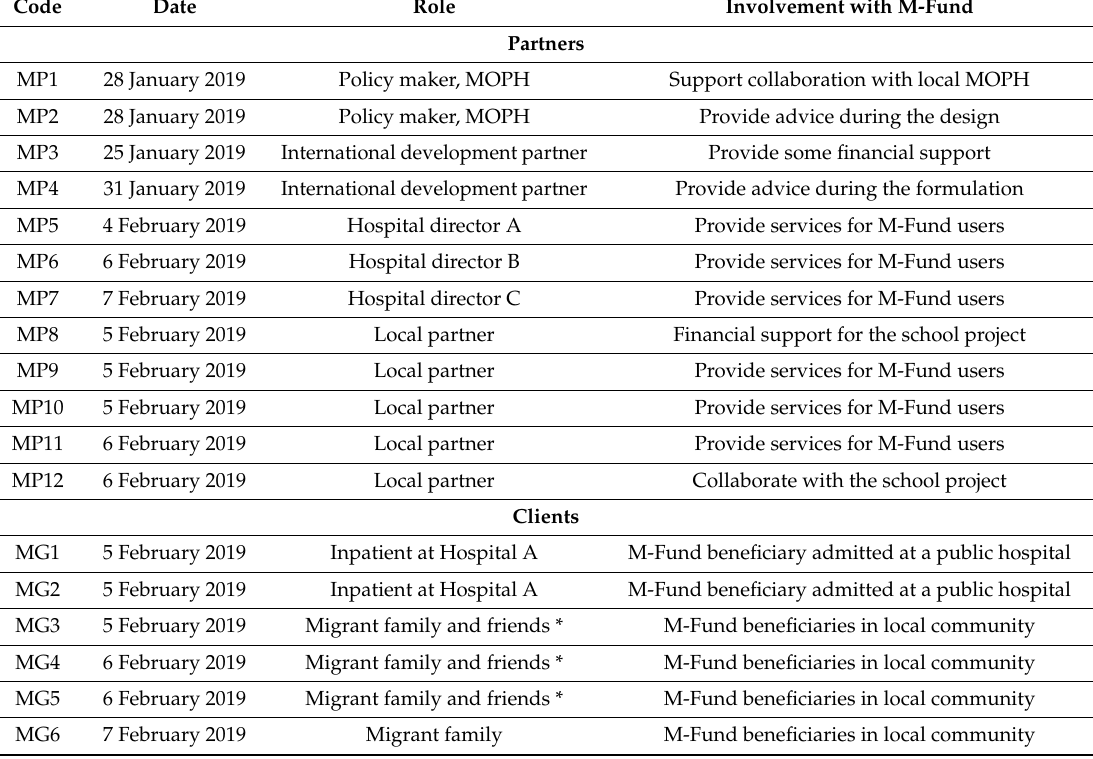
Table 1. List of